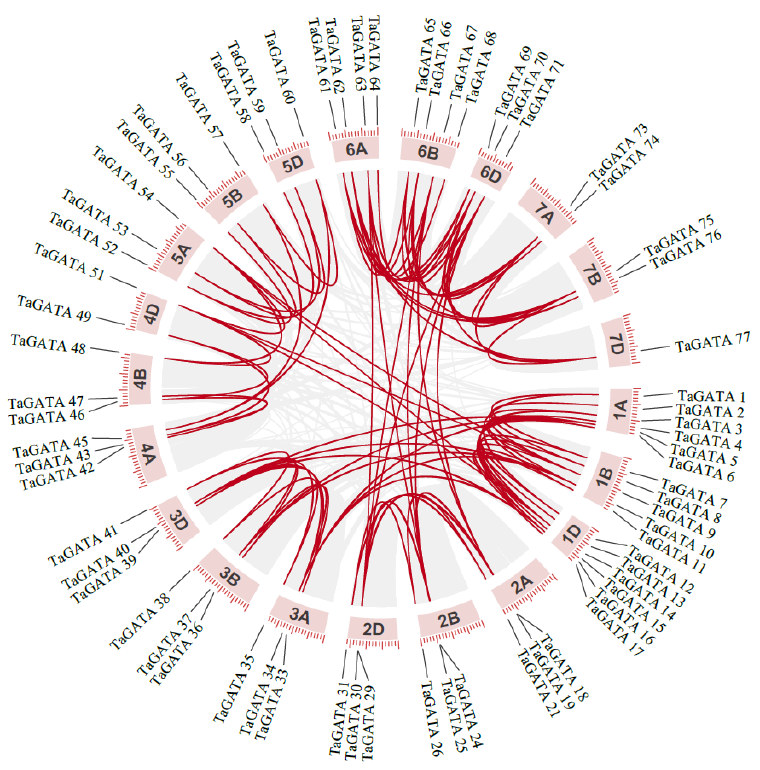
Figure 3. The chromosome distribution and collinearity of wheat GATA genes.